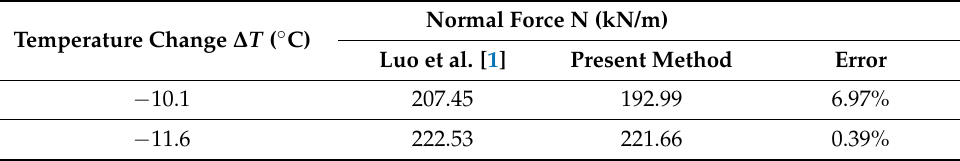
Table 2. Inner thermal forces of tunnel lining from Luo et al. [1] and the present method.